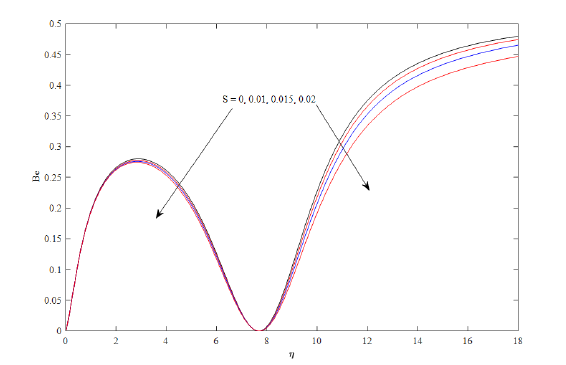
Fig. 10 Bejan number with varying S when Br = 1 , Q = 1 , M = 1 , X = 2 , Pr = 2 , ω = 1 , K = 0 . 95